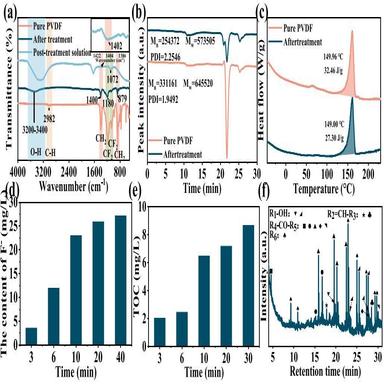
(a). FT-IR spectra of pure PVDF and after treatment in USFH, (b). Molecular weight changes before and after degradation of PVDF measured by GPC, (c). DSC thermogram of pure PVDF and after treatment in USFH, (d). The change of F- content in the solution, (e). The change of TOC in solution, and (f). GC–MS of the extract from reacted solution.